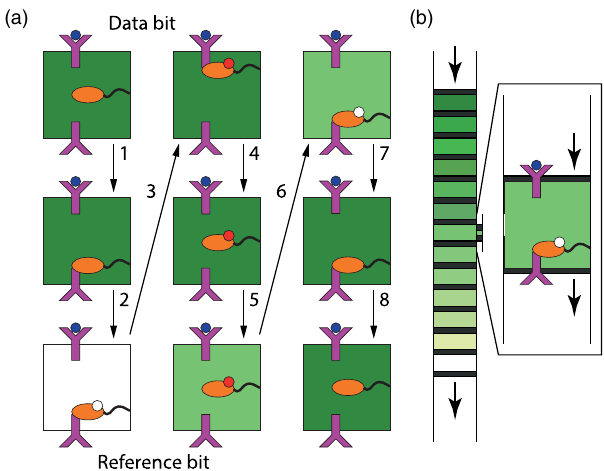
FIG. 5. A biochemical implementation of an optimal device and copy protocol. The cycle is illustrated in (a), and the steps are explained in the text. The system contains two receptors: one acting as a reference bit in state R for resetting and a receptor acting as a data bit in state RL or R . These receptors are attached to either end of a reaction volume. A readout molecule (memory bit) is tethered to the side of the reaction volume. The color of the reaction volume indicates the chemical potential of fuel mole- cules in solution: it is dark when Δ G p , Δ G d are large and negative and white when Δ G p , Δ G d ¼ 0 . (b) A device for implementing this cycle. A small reaction volume is coupled to a piston containing a series of reservoirs of varying ATP, ADP, and P content. Similarly, the receptors and readout can be brought in and out of proximity by manipulation of a second